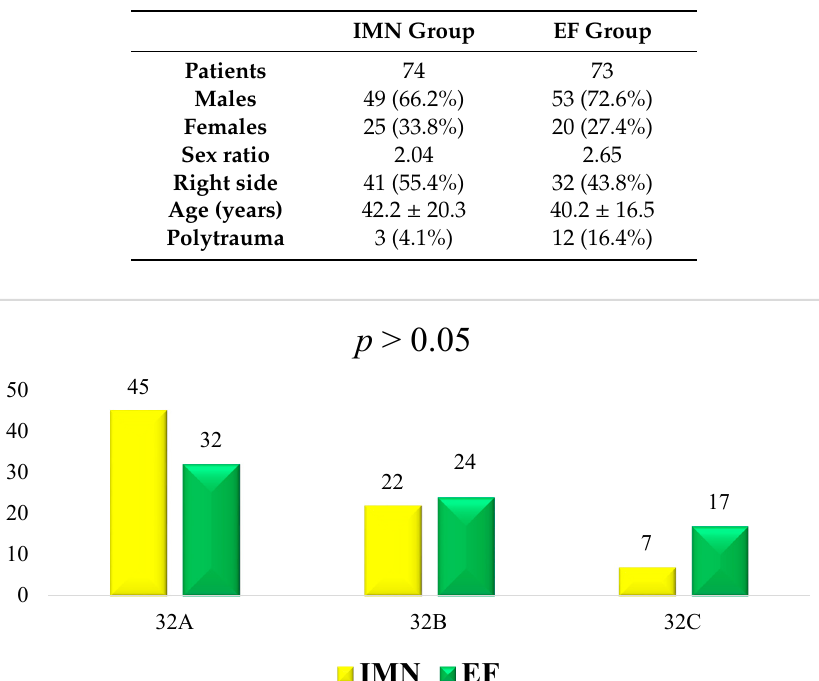
Table 1. Patients and methods: intramedullary nailing (IMN) versus external fraction (EF) group.